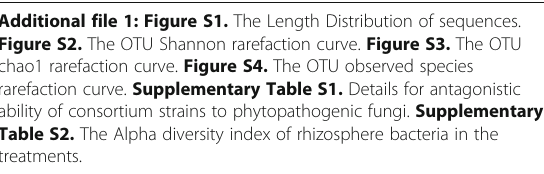
Additional file 1: Figure S1. The Length Distribution of sequences. Figure S2. The OTU Shannon rarefaction curve. Figure S3. The OTU chao1 rarefaction curve. Figure S4. The OTU observed species rarefaction curve. Supplementary Table S1. Details for antagonistic ability of consortium strains to phytopathogenic fungi. Supplementary Table S2. The Alpha diversity index of rhizosphere bacteria in the